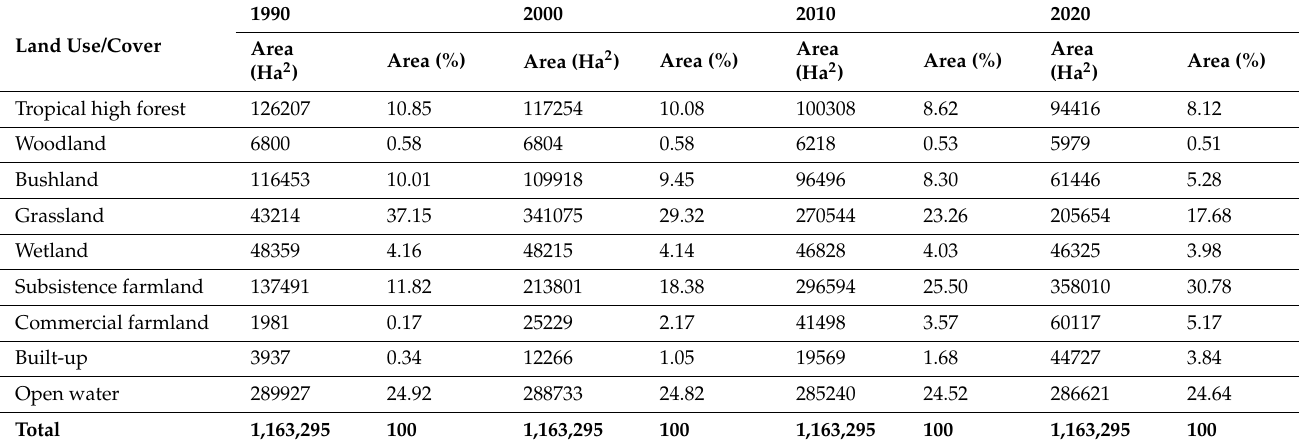
Table A4. LULC classification maps for Budongo–Bugoma landscape 1990–2020.